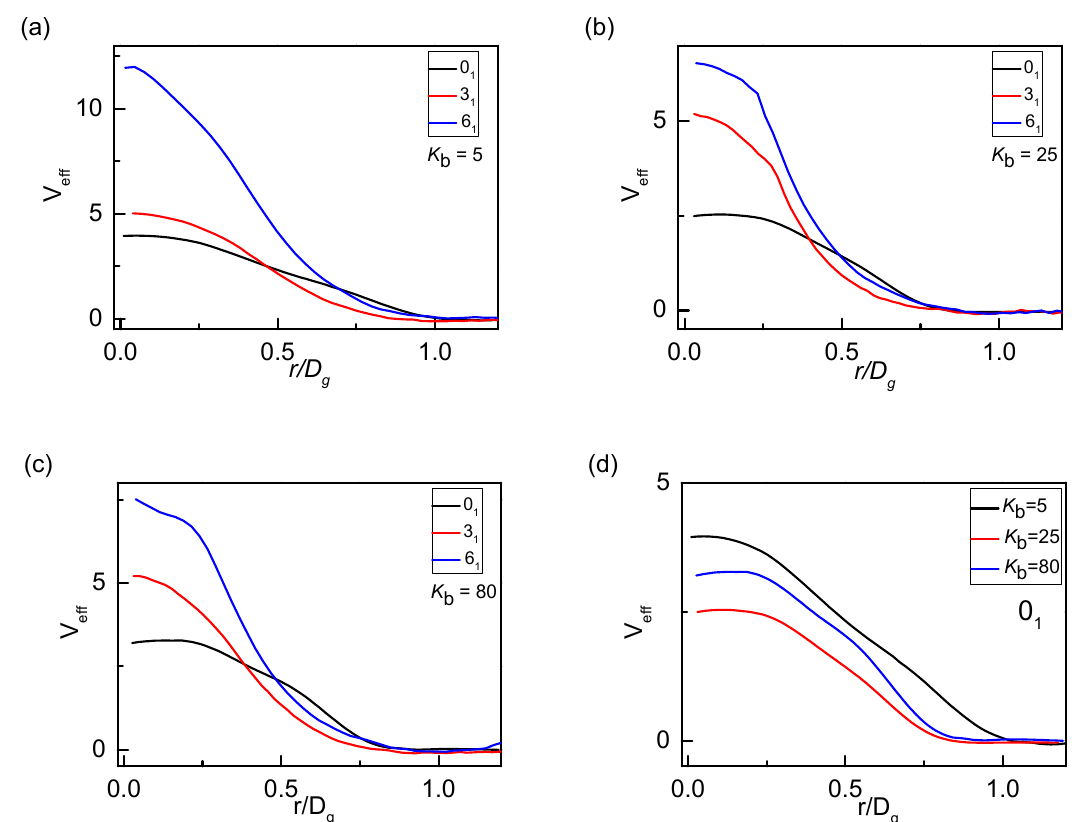
Figure 10. Potential of mean force (PMF) of three knot types ( a – c ) and 0 1 -knot rings shows the strong repulsion due to the topology constraints at short distances, resulting in the shift of the peak of P(r) in Figure 3 ( d ) PMF for different bending energies K b present a similar non-monotonous dependence on K b . Figure 11. The peak position shifts to the small bending energy a little when chain length increases from N = 64 to N = 256. For example, the peak is located at K b = 25 for N = 256 and at K b = 20 for N = 128 or 64. Meanwhile, the longer of the ring, the larger of the free space for penetration